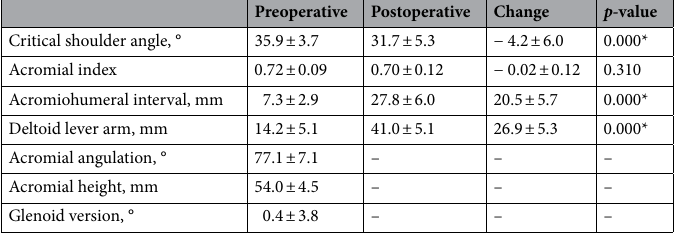
Table 3. Radiographic variables: preoperative, postoperative, and change. *Statistical significance.